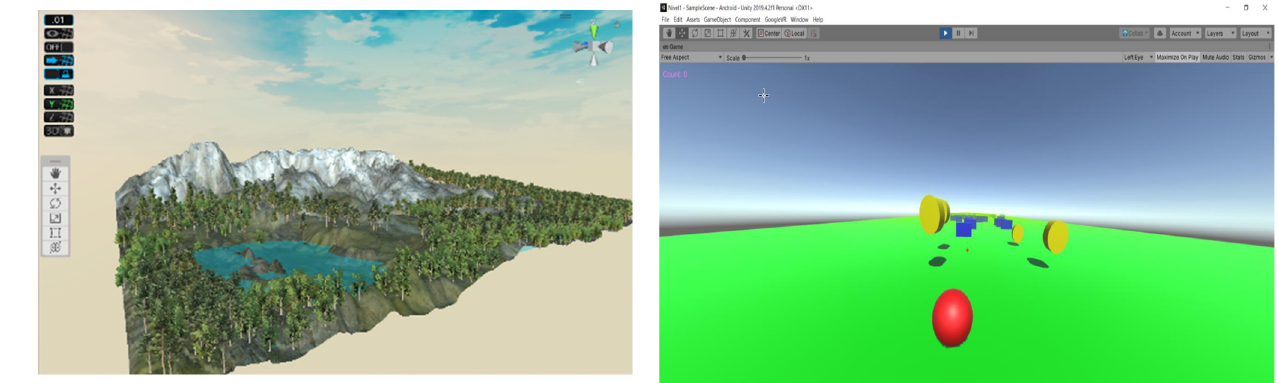
Figure 9. The VR application module to encourage adherence to the rehabilitation process.